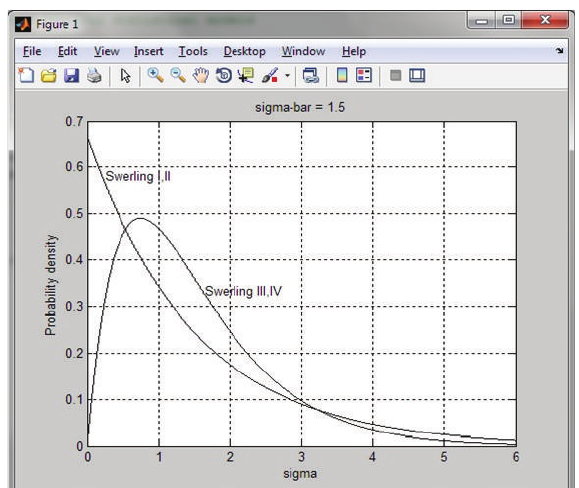
Figure 18: GUI for RCS of complex